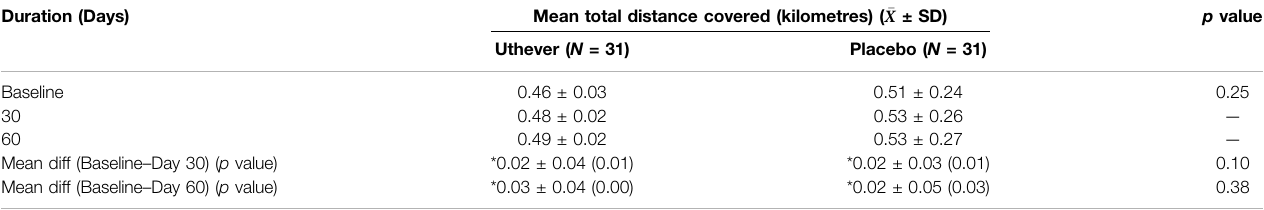
TABLE 3 | Comparison of changes in total distance covered in (6 Minute Walk Test) between the groups. Duration (Days) Mean total distance covered (kilometres) ( (cid:1) Χ ±